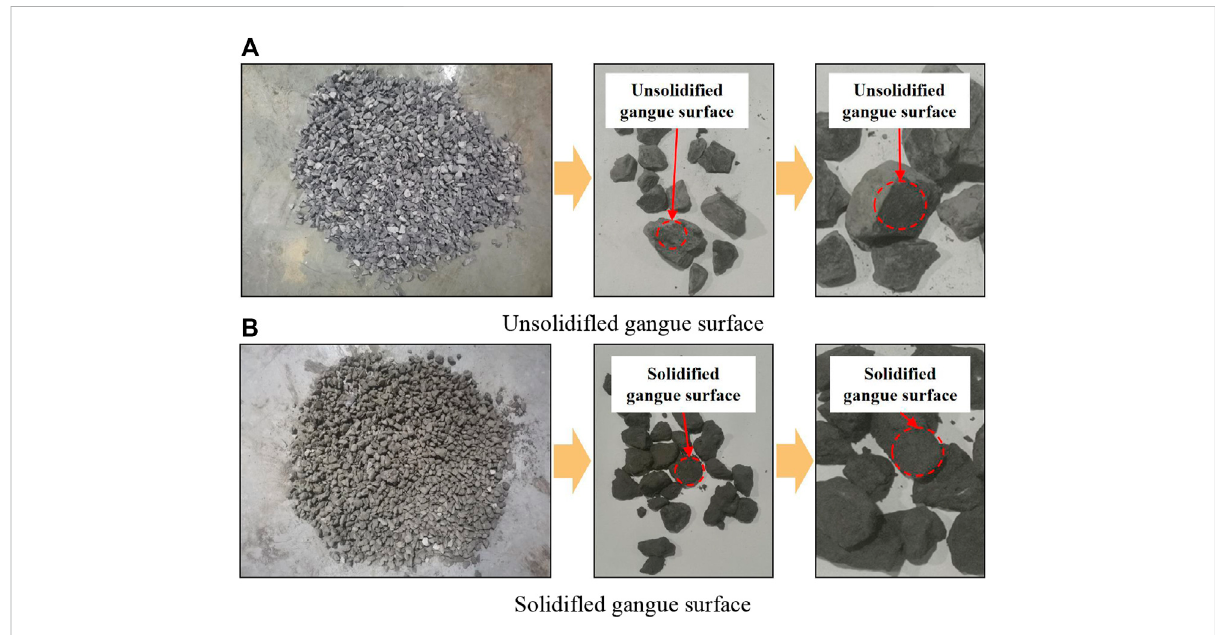
FIGURE 8 Comparison diagram of gangue surface before and after solidi fi ed. (A) Unsolidi fl ed gangue surface (B) Solidi fl ed gangue surface.